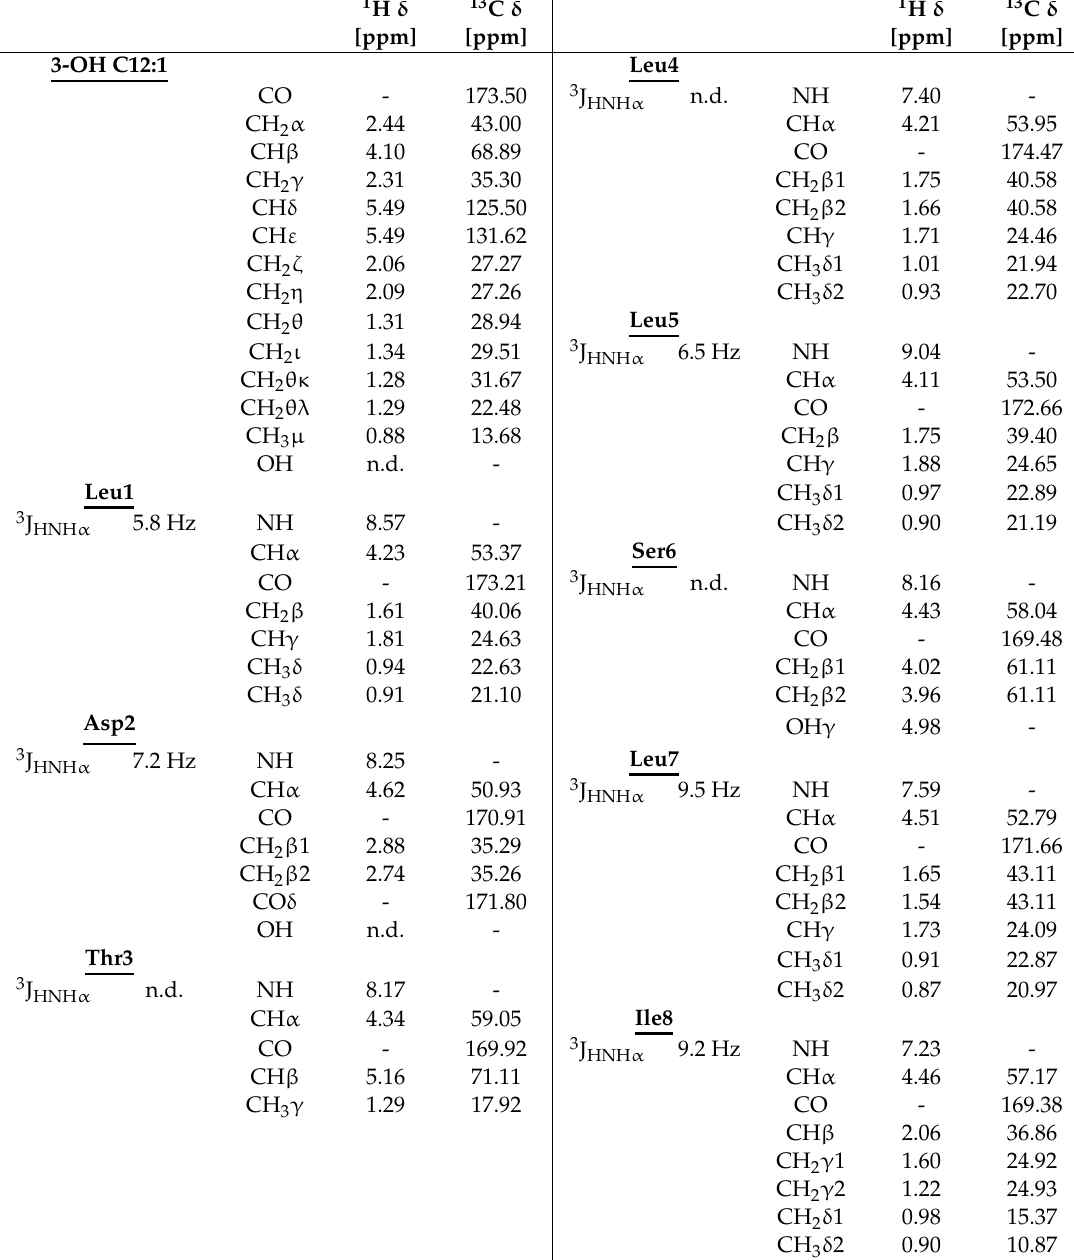
Table A1. 1 H and 13 C chemical shift of ‘bananamide D’ at retention time 12.4 min, in DMF-d 7 (298 K, 500